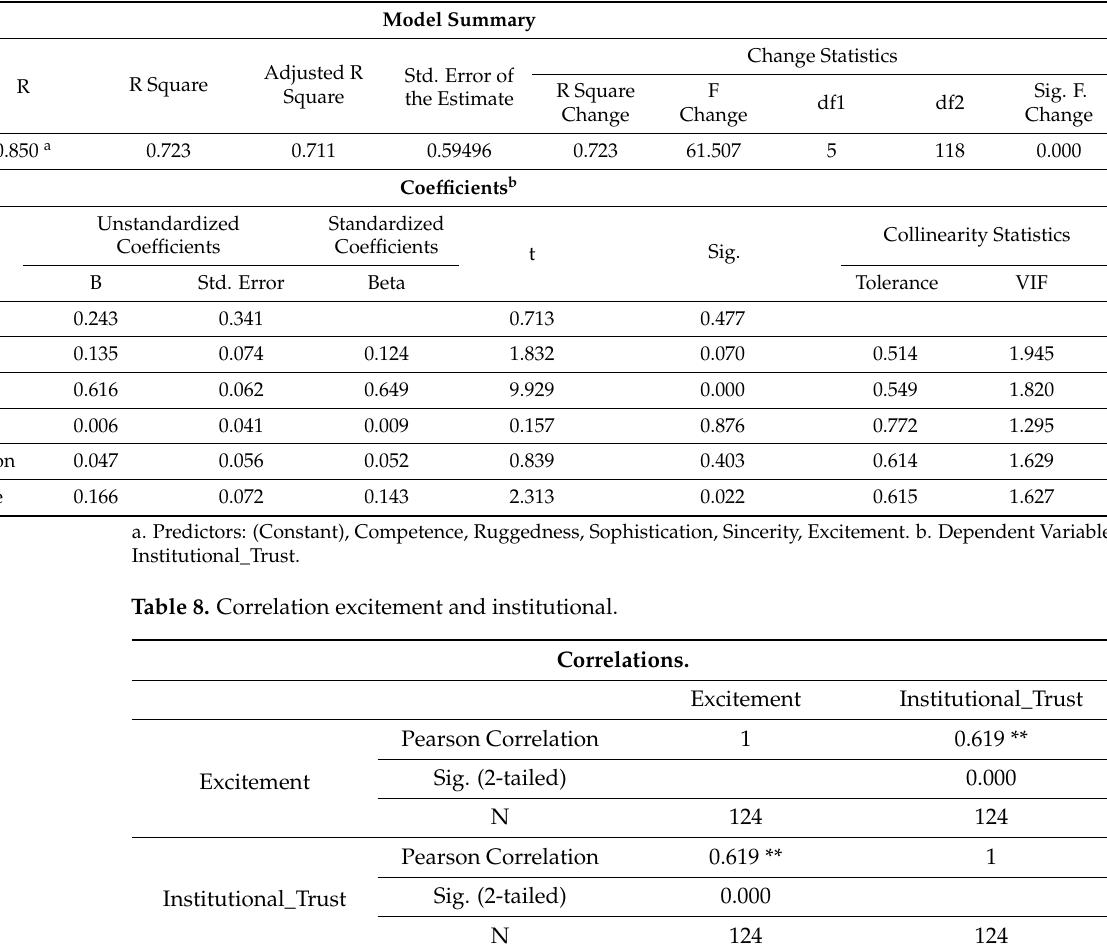
Table 7. Regression testing results. Brand personality dimensions and institutional trust.